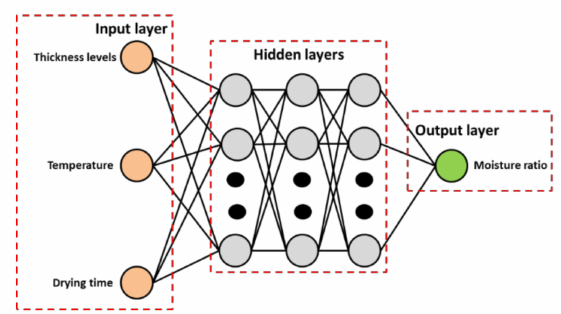
Figure 1. Artificial Neural networks topology with three hidden layers and di ff erent number of